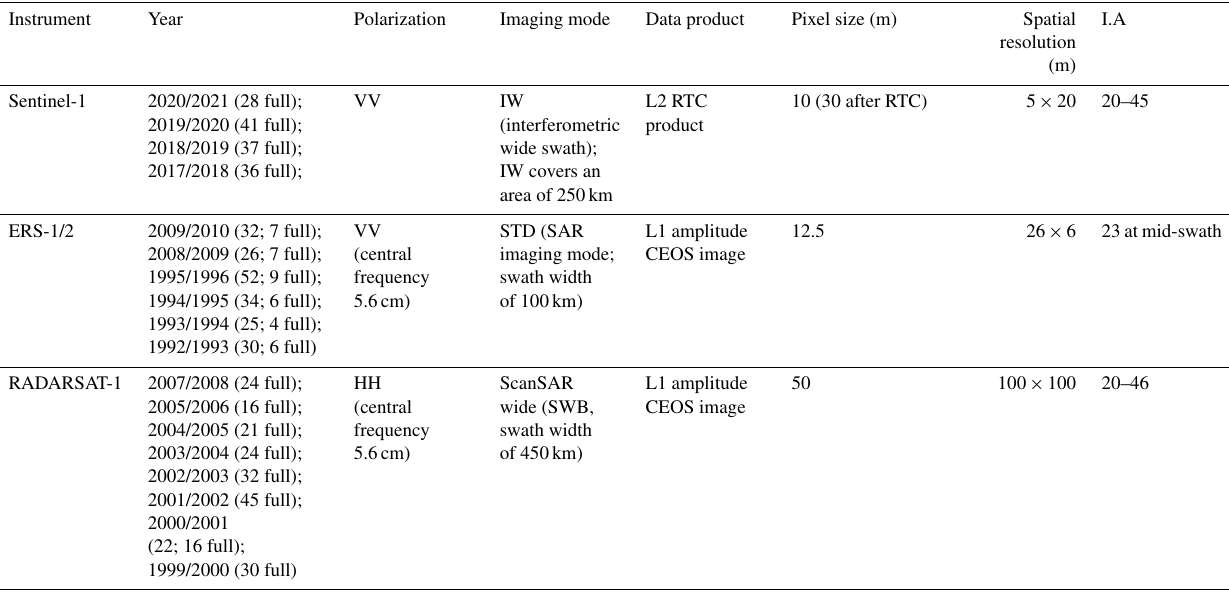
Table 1. Data used in the project (I.A. stands for incidence angle); number of scenes is indicated for each year, where “full” indicates the no. of full coverage scenes of the